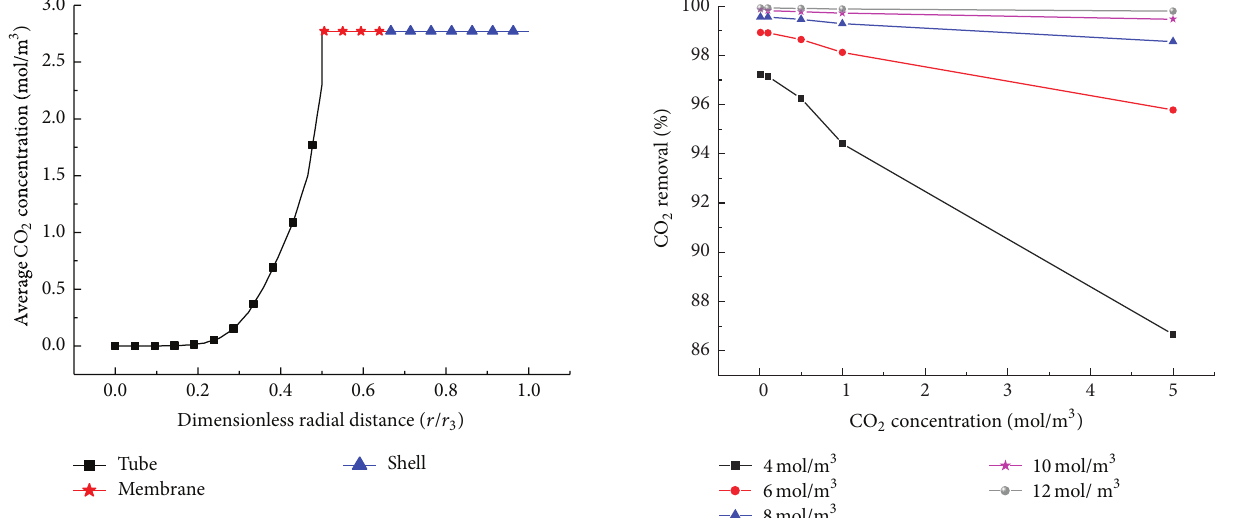
= 0.2 m s −1 , V CO 2